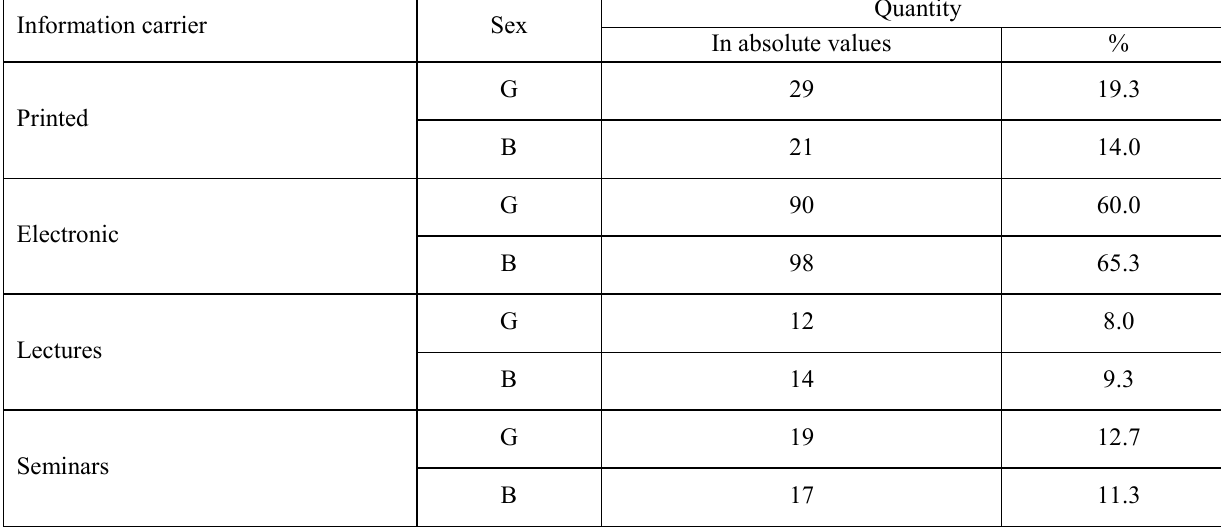
Students’ preferences in usage of information carriers for formation of health related motor functioning